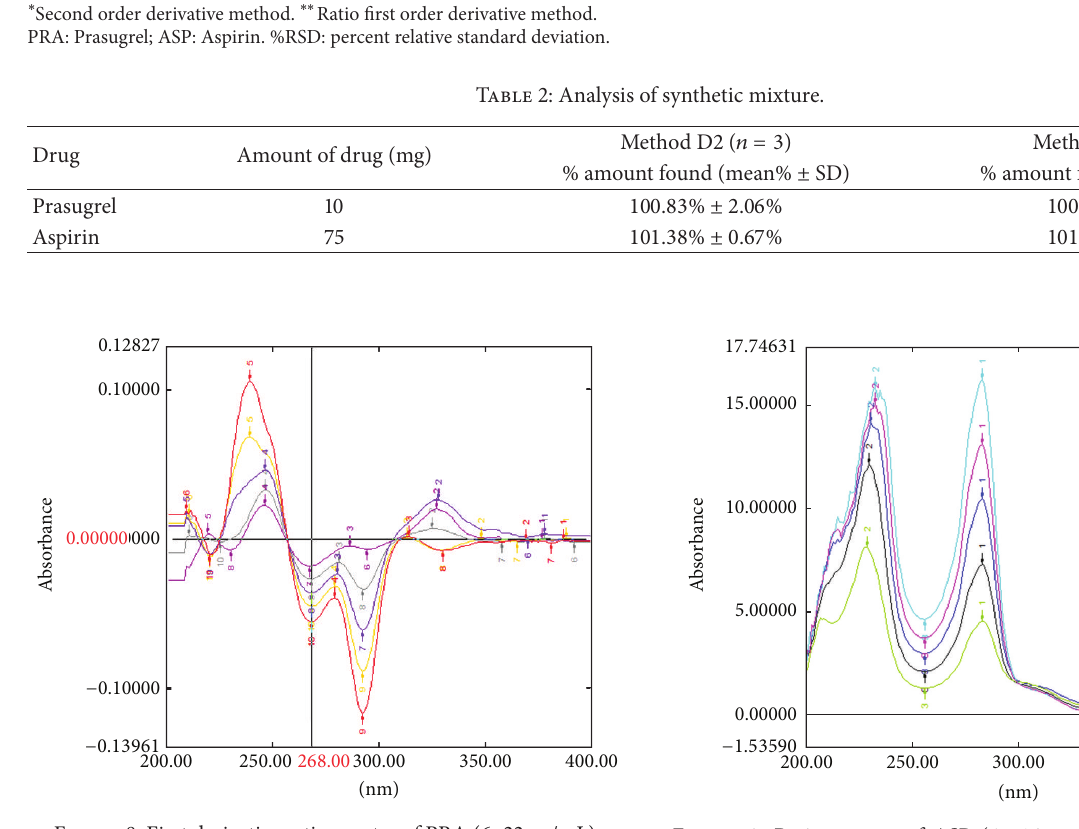
Figure 8: First derivative ratio spectra of PRA (6–22 𝜇 g/mL). Figure 9: Ratio spectra of ASP (45–165 𝜇 g/mL) using 10 𝜇 g/mL solution of PRA as